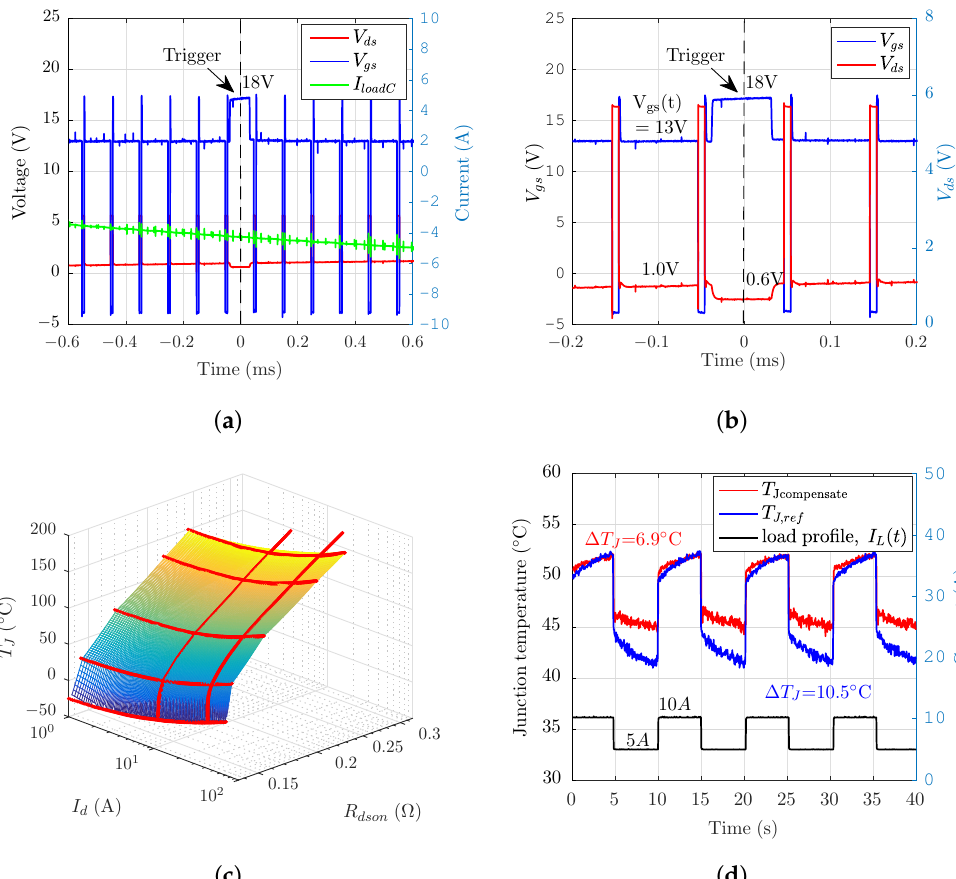
Figure 13. ( a ) V ds response of the three-level gate signal, ( b ) V ds response of the three-level gate signal zoom in view, ( c ) Look-up table for junction temperature T J estimation, and ( d ) Load profile and temperature profile during power cycling